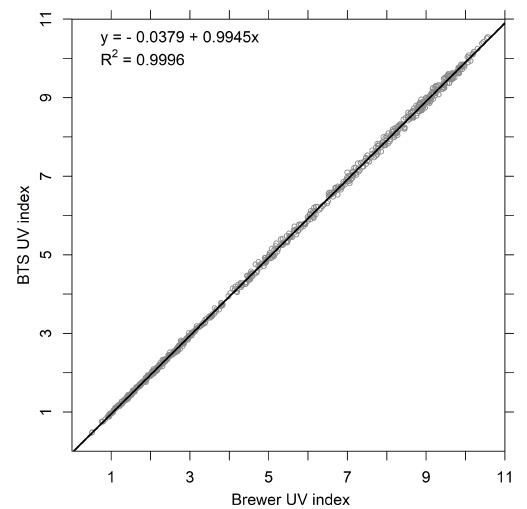
Figure 5. Synchronized UV index obtained from the BTS versus the UV index from the Brewer #150. The measurements were derived from cloud-free conditions and SZAs below 70 ◦ combining all the available data of the three measurement campaigns (711 pairs of UV index